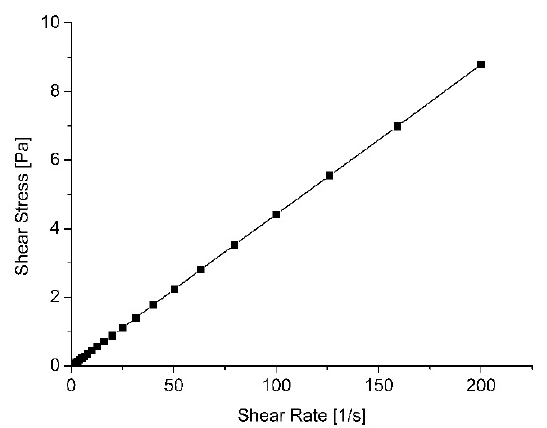
Figure 3. Flow curve for in situ gels G1–G6 (shear rate vs. shear stress); all formulations showed the same parameters.